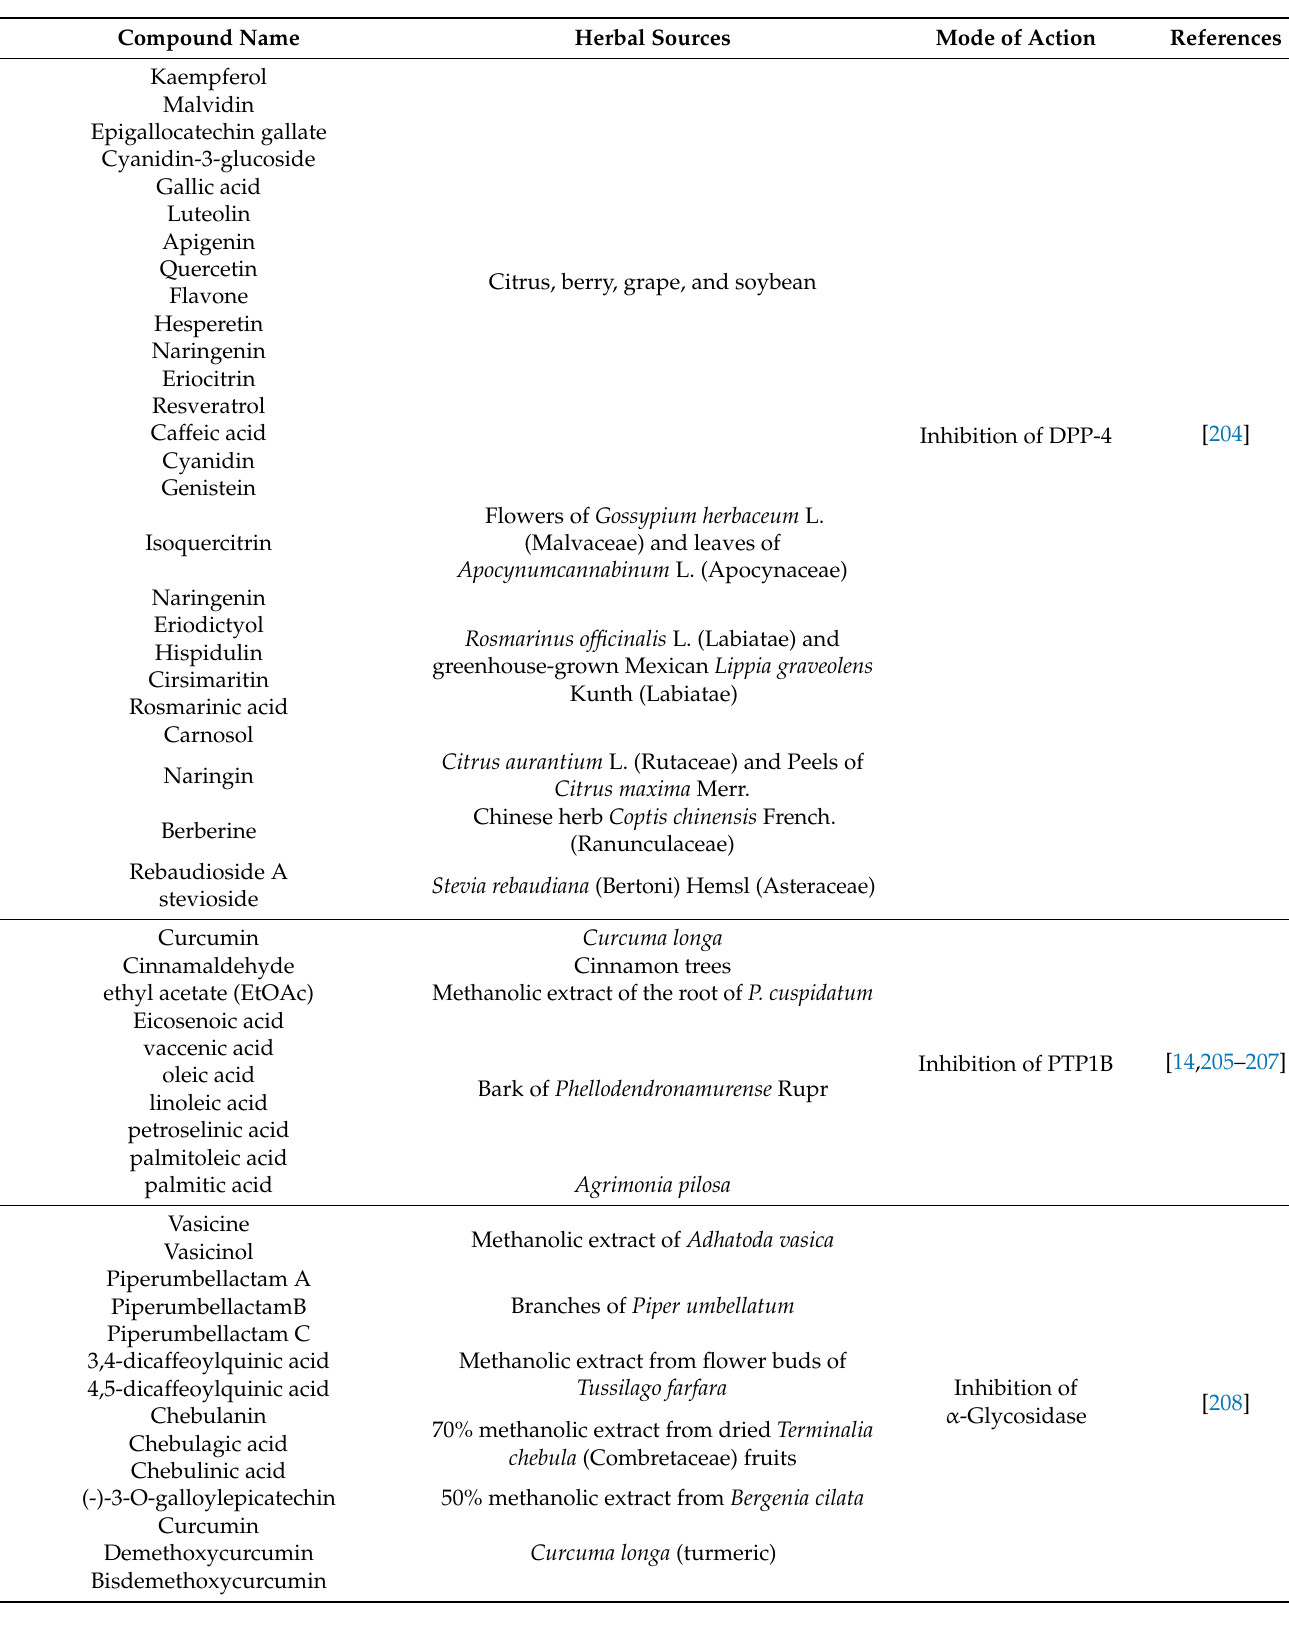
Table 1. Herbal therapeutics with their mode of action against